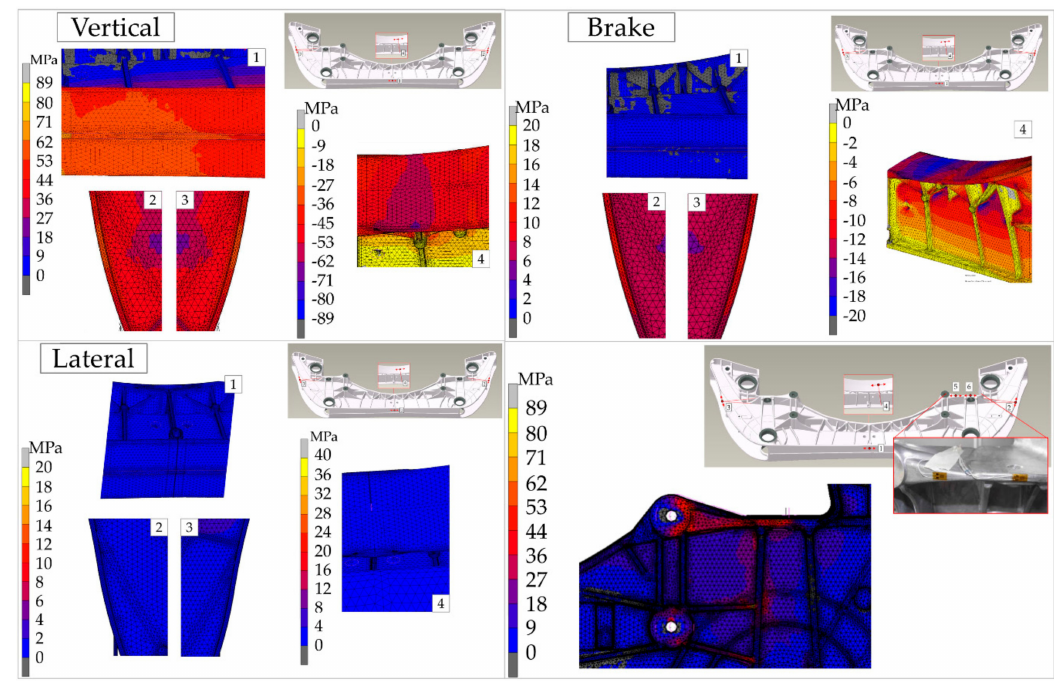
Figure 9. MSC Marc / Mentat principal stress outputs, focusing on the strain gauges